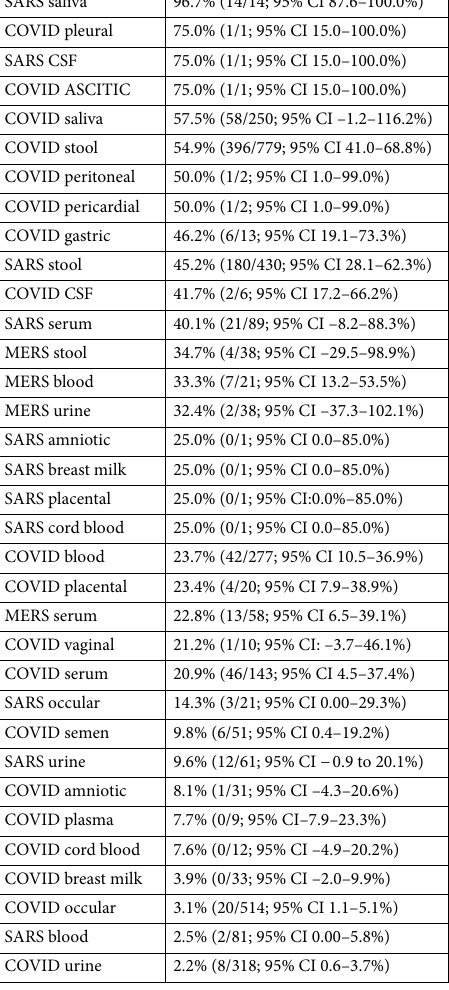
Table 4. Pooled positivity of SARS, MERS, SARS CoV-2 in different non-respiratory samples from highest to